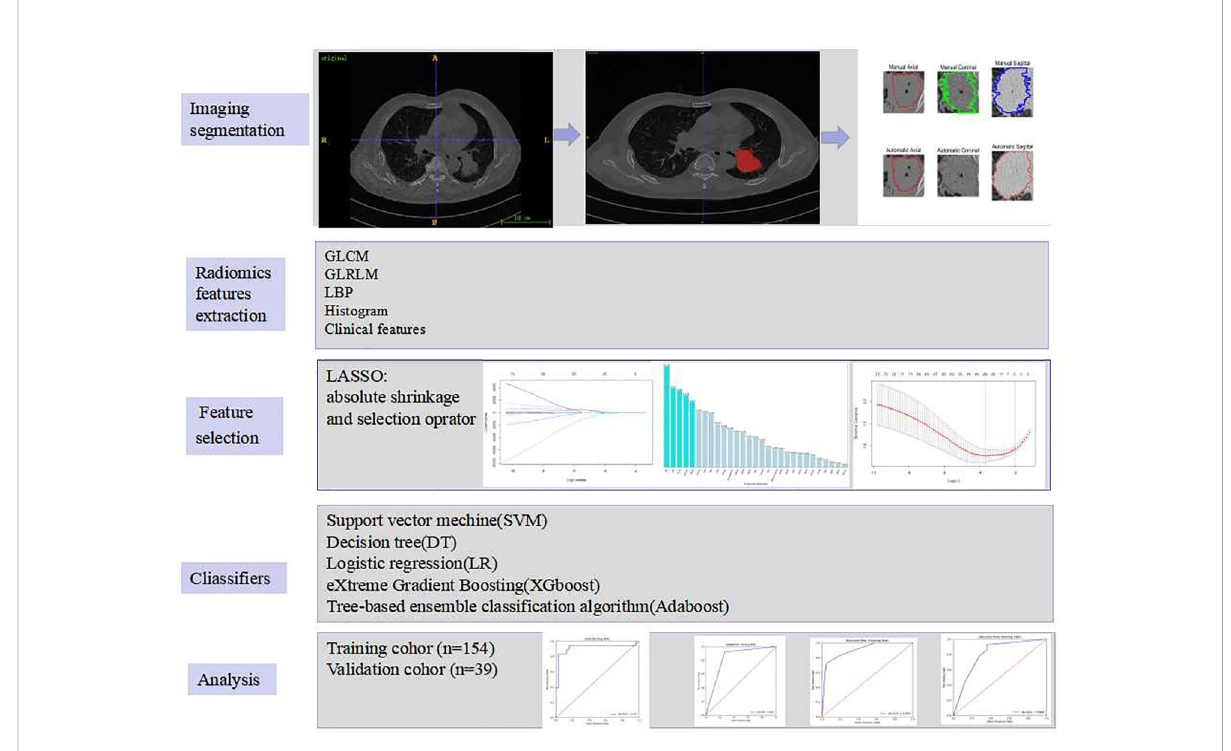
FIGURE 2 The radiogenomics framework of this